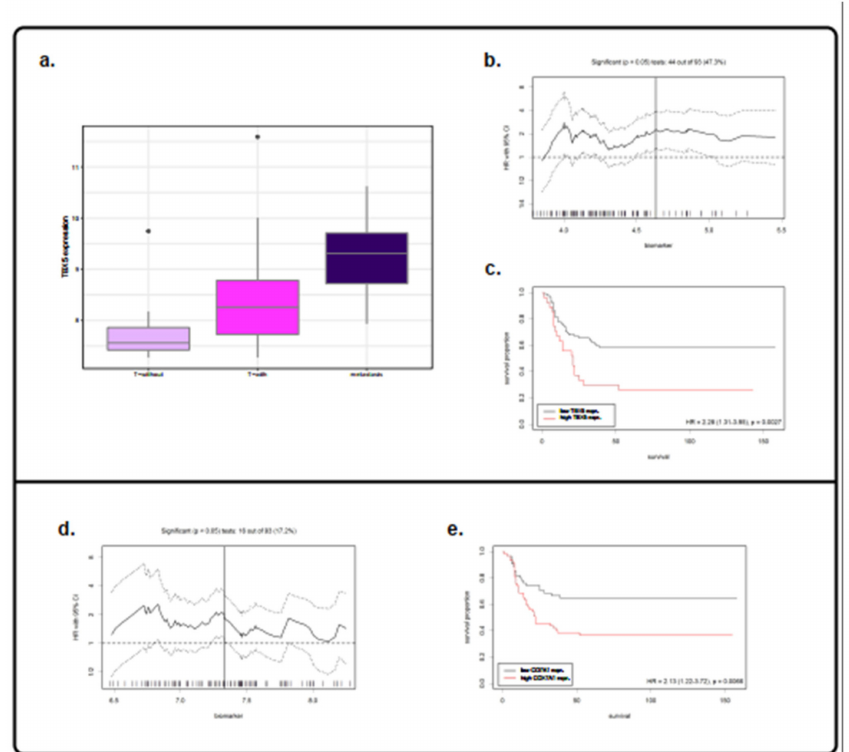
Figure 4. TBX5 expression levels and TBX5 and COX7A1 evaluation in Cromer–Rickman combined dataset. ( a ) The boxplots depict the expression of TBX5 in the T-without, T-with, and distant metastasis (DM) tumors. ( b ) Optimal cuto ff values using Cuto ff Finder for TBX5. The plot shows the hazard ratio (HR) for DM-free survival (DMFS) at various cuto ff points of TBX5 expression values. The vertical line defines the optimal cuto ff value, as the point with the most significant HR. The solid and broken lines indicate the HR and the 95% confidence intervals for each HR, respectively. ( c ) Kaplan–Meier curves for TBX5 expression divided based on the best cuto ff . The black and red lines indicate the group with low and high values, respectively. ( d ) Optimal cuto ff values via Cuto ff Finder for COX7A1. The plot shows the HR. ( e ) Kaplan–Meier curves of COX7A1 expression divided based on the best cuto ff